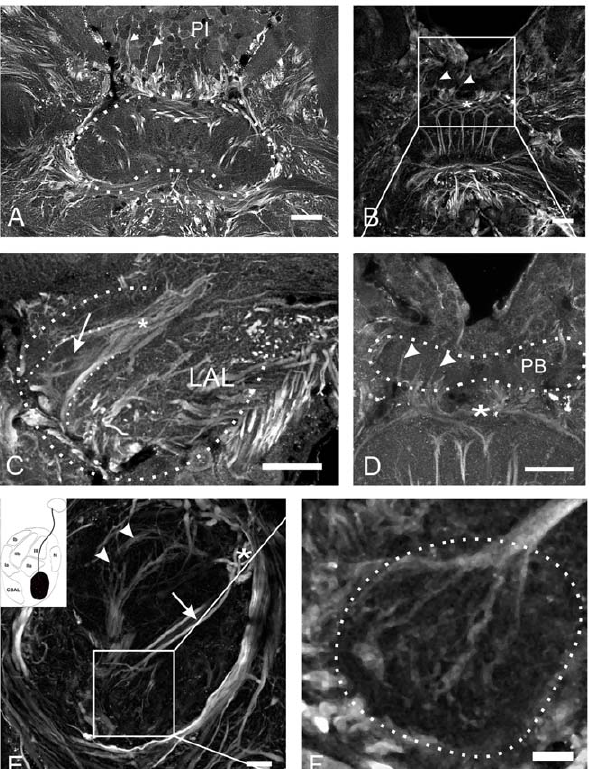
Figure 2. Muscarinic ACh receptor-immunoreactivity (mAChR- ir) in the central complex. A–D: Frontal sections of the central complex. MAChR-ir is restricted to columnar fibers whose somata are located in the pars intercerebralis (PI). These neurons send small neurites into the protocerebral bridge (PB) (arrowheads in A, B and D). The main fibers project as large diameter neurites via four pairs of fiber bundles, the w-, x-, y- and z-bundles through the posterior chiasm (indicated by white asterisk in A, B, D and E) between the protocerebral bridge and the central body and innervate single columns of the lower division. The fibers run to the contralateral lateral accessory lobe (LAL) via the isthmus tract (indicated by white asterisk in C) and seem to terminate in the lateral triangle (indicated by arrow in C). E: Sagittal section through the central body with two types of mAChR-ir columnar fibers. One type (indicated by arrowheads) runs through layer I of the CBU and passes along the anterior border of the CBL, while the other type projects through layer III as part of the posterior vertical bundle (indicated by arrow) and innervates the CBL (The inset describes the projection pattern of the second type; modified from [18,21]. F: Sagittal section of the CBL. The arborization pattern in the lower division is not restricted to a certain layer but extends rather diffusely throughout the entire CBL. Smooth appearance of neurites indicates their post-synaptic character. Scale bars=50 m m in A, B, C and D; 20 m m in E; 10 m m in F.